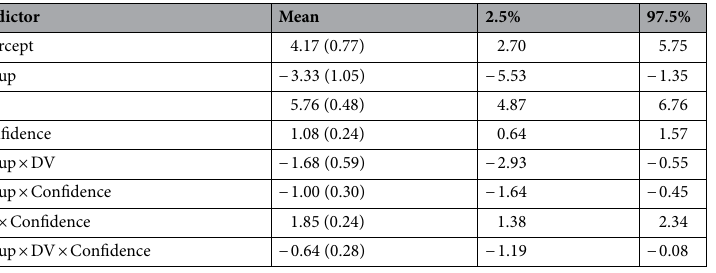
Table 2. Results of Bayesian MGLM in the confidence accuracy task, regressing binary choices (0 = immediate reward, 1 = delayed reward) on predictors for Group (0 = nonsmoker, 1 = smoker), difference in value (DV), confidence, and the interaction terms. We report the upper and lower borders of the 95% HDI of the posterior distributions. Standard errors of the mean are in brackets.